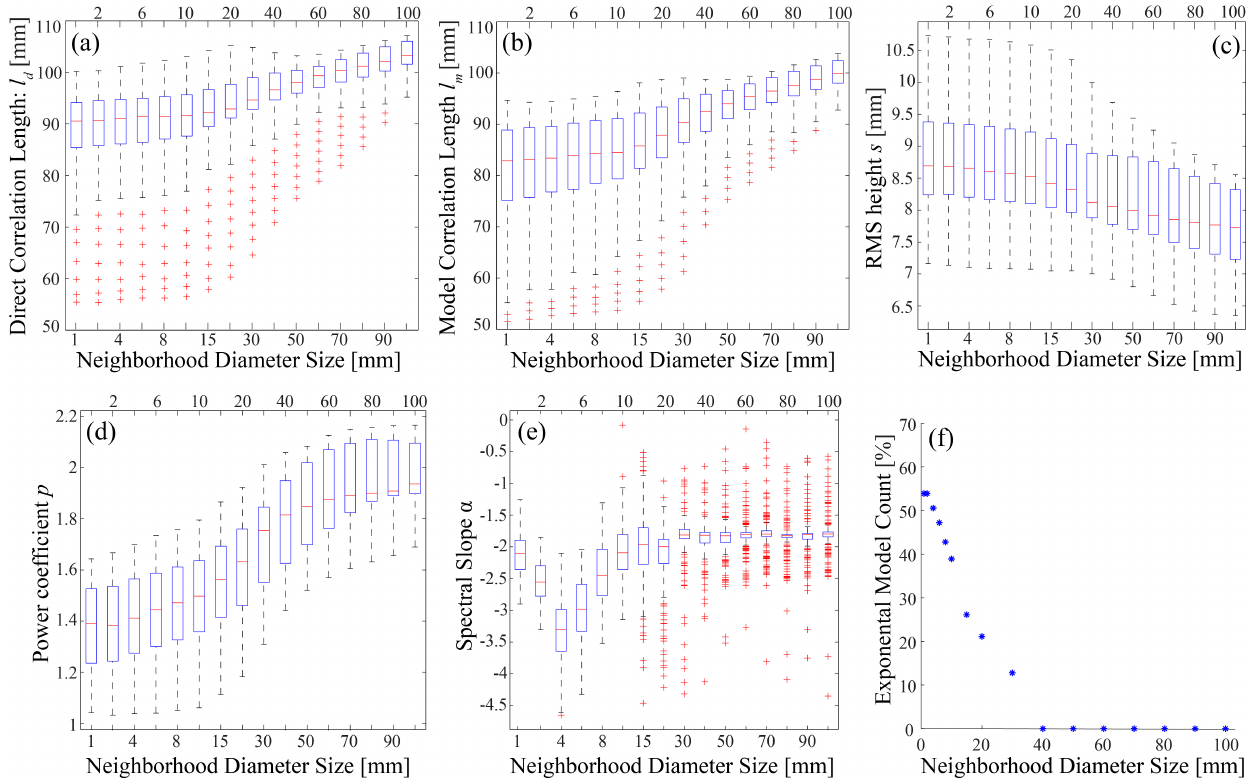
Figure 6. ( a – e ) Roughness indices l diameter; ( f ) The percentage of the exponentially correlated profiles as a function of the neighborhood diameter; The parameters were estimated from the DEM Set 1, where only Scan 1 was